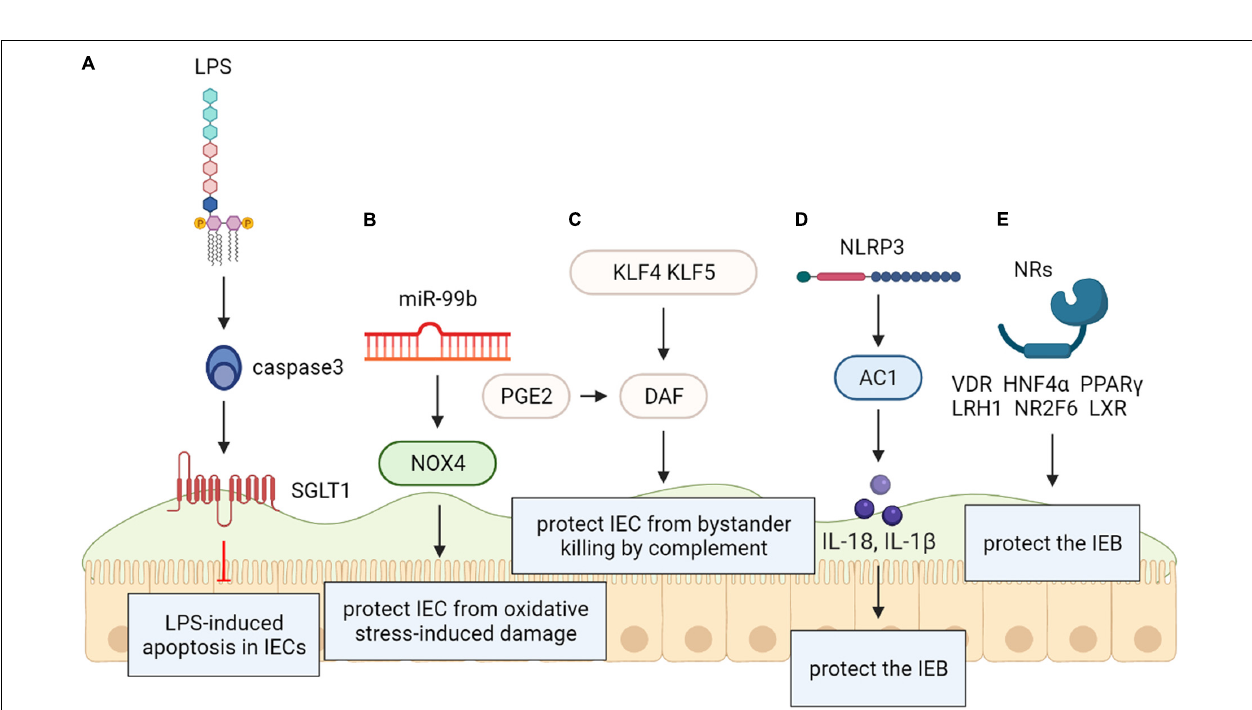
FIGURE 6 | (A) Lipopolysaccharide (LPS/CD1) protects the intestinal epithelial barrier. SGLT-1-mediated glucose uptake may be activated by CD14 activation in intestinal epithelial cells, independently of TLR-4, for the protection of the epithelium against LPS-induced apoptosis. (B) NADPH oxidase 4 (NOX4) protects the intestinal epithelial barrier. The intestinal epithelium from oxidative stress-caused damage may be protected by MiR-99b-mediated NOX4 downregulation. (C) Krüppel-like factors (KLF) protect the intestinal epithelial barrier. Rapid protection against complementary attacks may be provided by synergistic induction of DAF by COX/PGE2and KLF4/5 after intestinal mucosal injury. (D) Recombinant NLR Family, Pyrin Domain Containing Protein 3 (NLRP3) protects the intestinal epithelial barrier. NLRP3 induced generation of IL-18 in intestinal epithelial cells can be protective. (E) Nuclear receptors (NRs) protect the intestinal epithelial barrier. Within the intestinal epithelium, NRs including VDR, HNF4 α , LXR, PPAR γ , LRH1, and NR2F6 exert protective effect on intestinal epithelial integrity.